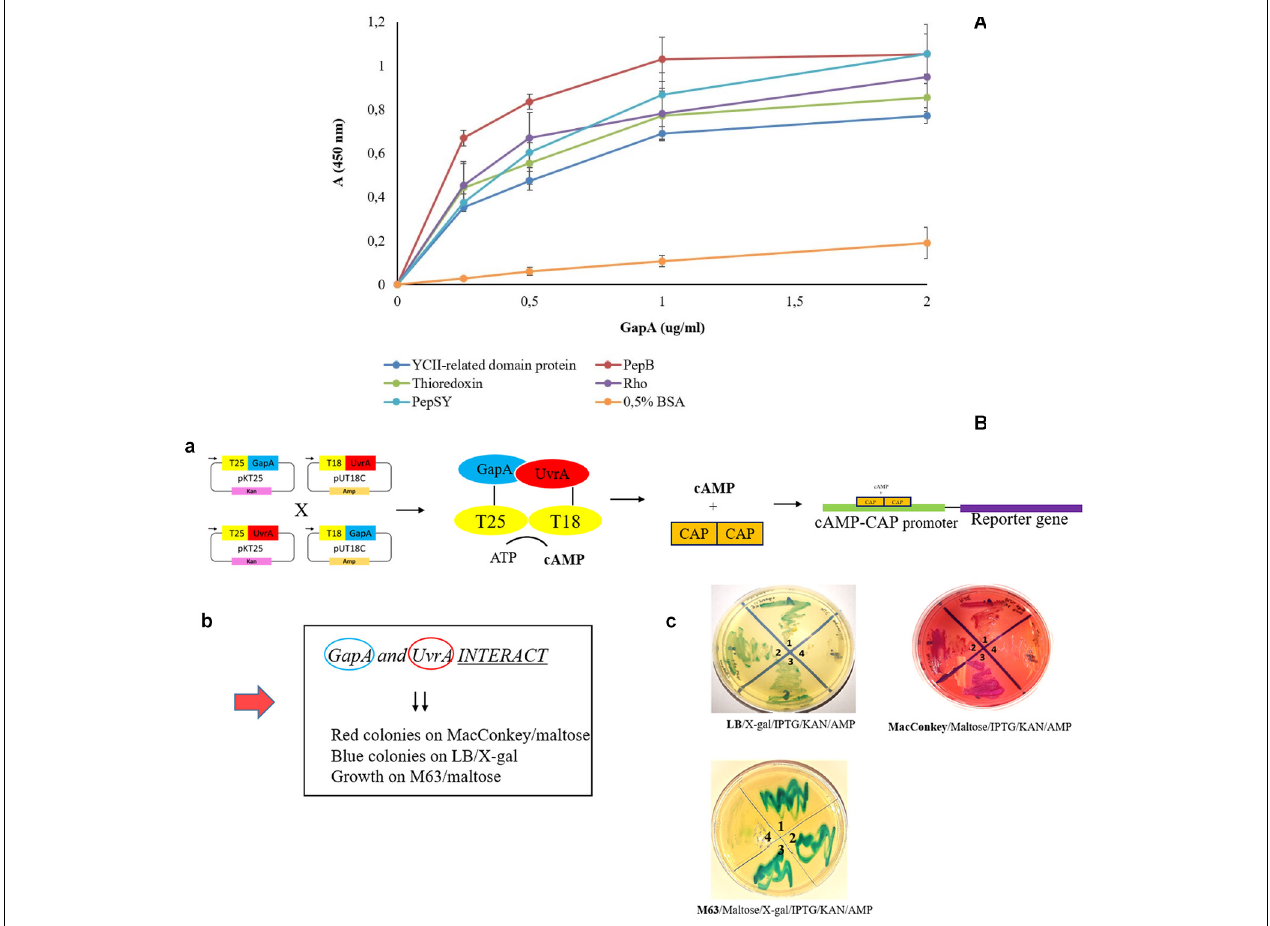
FIGURE 2 | Validation of F. tularensis GapA binding ability to selected bacterial proteins. (A) Solid-phase binding assay of PepSY, Rho, thioredoxin, PepB, YCII-related domain protein, and BSA (negative control) coated on 96-well microtiter plate and reacted with different concentrations of purified GapA. Data are presented as means ± SD from three independent experiments. (B) Validation of GapA and UvrA interaction using the BACTH system. (a) Principle of the method: GapA and uvrA genes were cloned into the plasmids pKT25 and pUT18C and fused with T25 and T18 fragments. During the interaction of GapA with UvrA, complementation occurs between T25 and T18 fragments with subsequent cAMP synthesis. The complex of cAMP/CAP is a pleiotropic regulator of gene expression ( E. coli ) that initiates expression of reporter genes ( lac , mal operon). (b) Manifestation of positive interaction. (c) BTH101 cells were co-transformed with the following plasmid combinations: (1) pKT25- gapA × pUT18C- uvrA , (2) pUT18C- gapA × pKT25- uvrA , (3) positive control plasmids pKT25 zip × pUT18C zip, and (4) negative control plasmids pkT25 empty + pUT18C empty. Co-transformed BTH101 cells with a plasmid combination were grown on selective agar plates (LB/X-gal/IPTG/KAN/AMP or MacConkey/Maltose/IPTG/KAN/AMP or M63/Maltose/X-gal/IPTG/KAN/AMP). The bacteria grown on LB agar plates were passaged on MacConkey agar plates and vice versa. We observed the results to be the same (data not